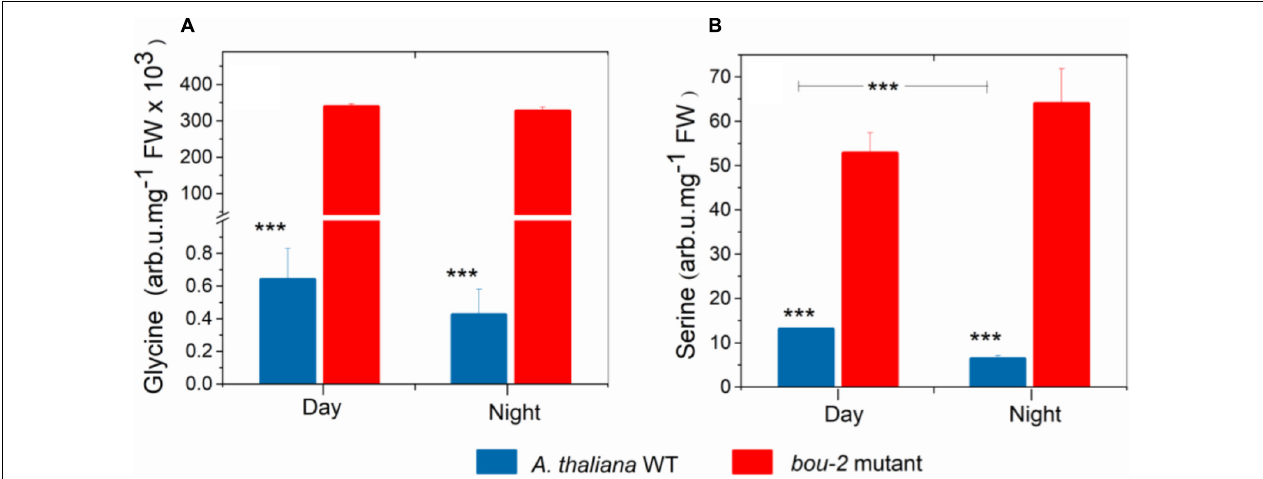
FIGURE 1 | Content of Glycine (A) , Serine (B) in leaves of A. thaliana WT and the bou - 2 mutant at day and night. Plants were grown at elevated (3000 ppm) CO 2 and harvested after 24h at ambient CO 2 ca. 10 min after light onset and 3 h before light onset. Asterisks indicate significant differences as determined by